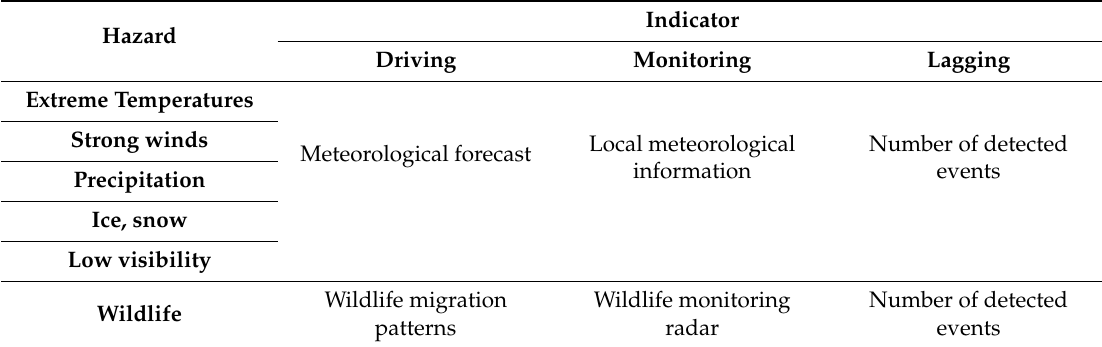
Table 7. Safety indicators regarding environmental factors.